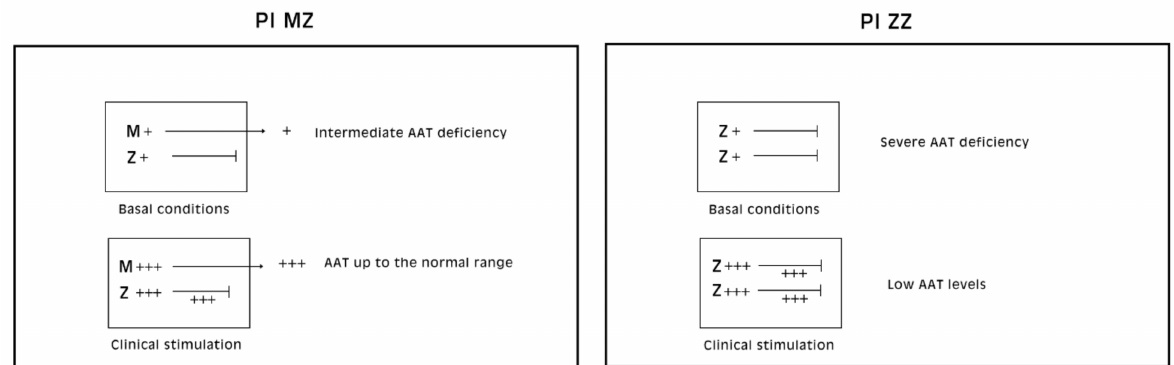
Figure 1. Schematic representation of “R-SB” phenomenon in Pi MZ and Pi ZZ phenotypes. Pi MZ individuals under basal conditions have partial (intermediate) AATD, as the M fraction is regularly exported whilst the Z fraction is retained within hepatocytes. Under conditions of clinical stimulation, the M fraction is increased in synthesis and export and raises the serum AAT levels up to the normal range. In the same time, the intracellular storage of the Z fraction increases; PiZZ individuals have low serum AAT levels either under basal or stimulatory